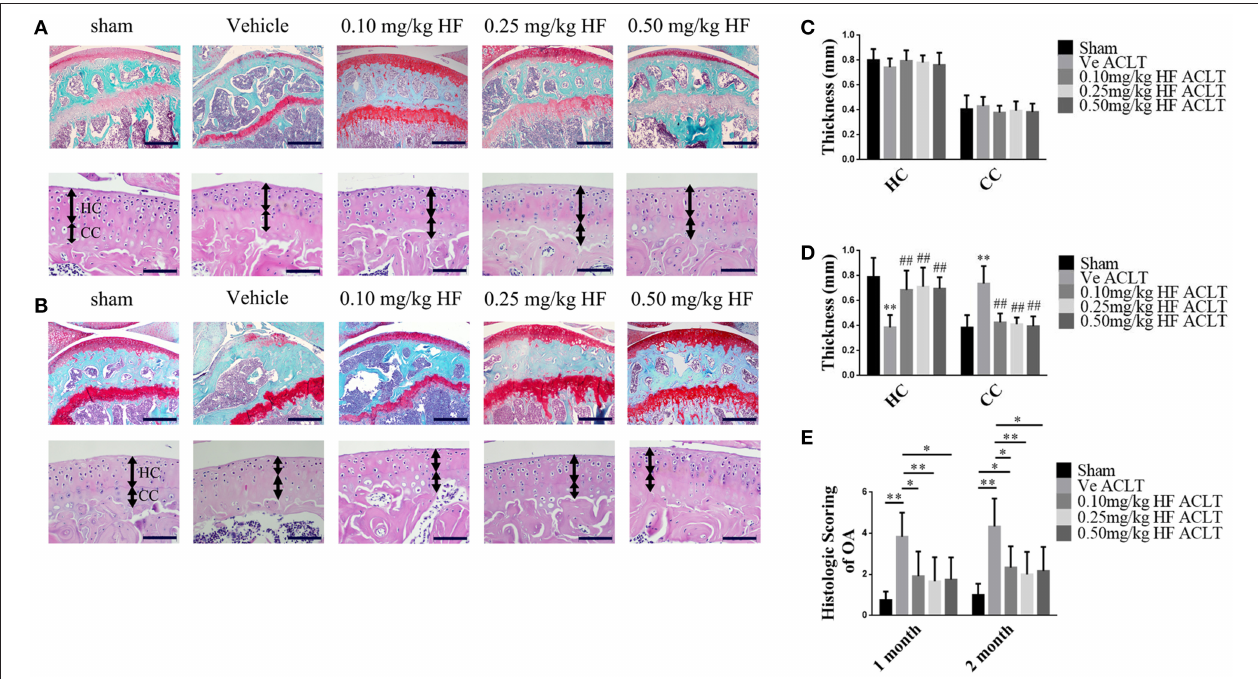
FIGURE 1 | HF, by oral gavage, prevented articular cartilage degeneration after ACLT at 30 d (A) and 60 d (B). Safranin O & Fast Green staining of sagittal sections of tibial medial compartment, where proteoglycan is in red and bone is in blue (top). Scale bar, 500 µ m. H&E staining (bottom), where thickness of HC and CC are marked by double-headed arrows. Scale bar, 100 µ m. HC and CC changes in thickness among different groups at 1m (C) and 2m (D) after sham surgery or ACLT. ** p < 0.01 compared to sham group, ## p < 0.01 compared to vehicle-treated ACLT group. (E) Histologic OA Score of articular cartilage at different time-points. * p < 0.05 as denoted by bar, ** p < 0.01 as denoted by